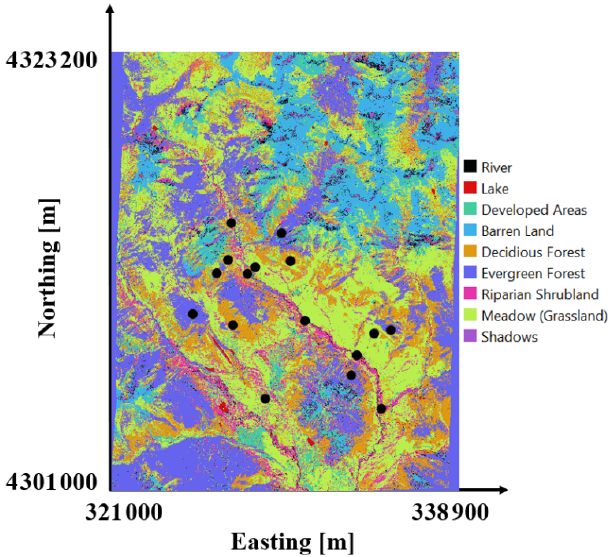
Figure 2. Vegetation classification of the East River Watershed, CO, from Falco et al. (2019). East River sites selected in this study are denoted by black